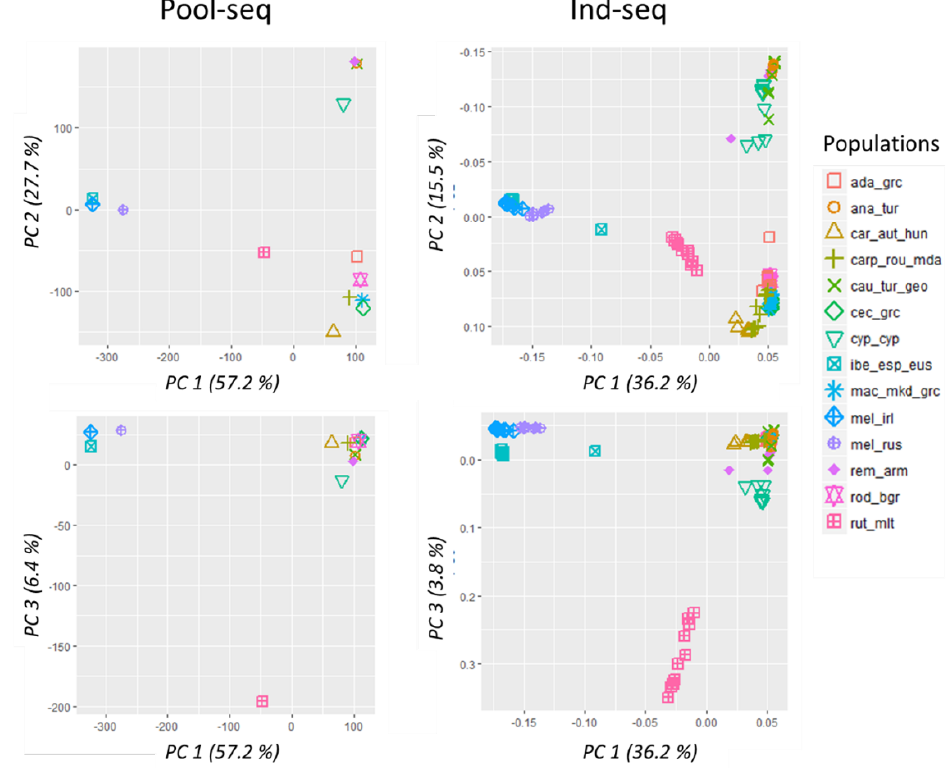
Figure 4. Principal component analysis (PCA) of pool-seq data ( left two panes ) and ind-seq data ( right panes ). Upper panels show the first and second principal components explaining most of the variance, while the lower panels display the first and third components, which only account for 6.4% and 3.8% of the total variation, respectively. M-lineage: ibe_esp_eus = A. m. iberiensis from Spain; mel_irl = A. m. mellifera from Ireland; mel_rus = A. m. mellifera from Russia; C-lineage: